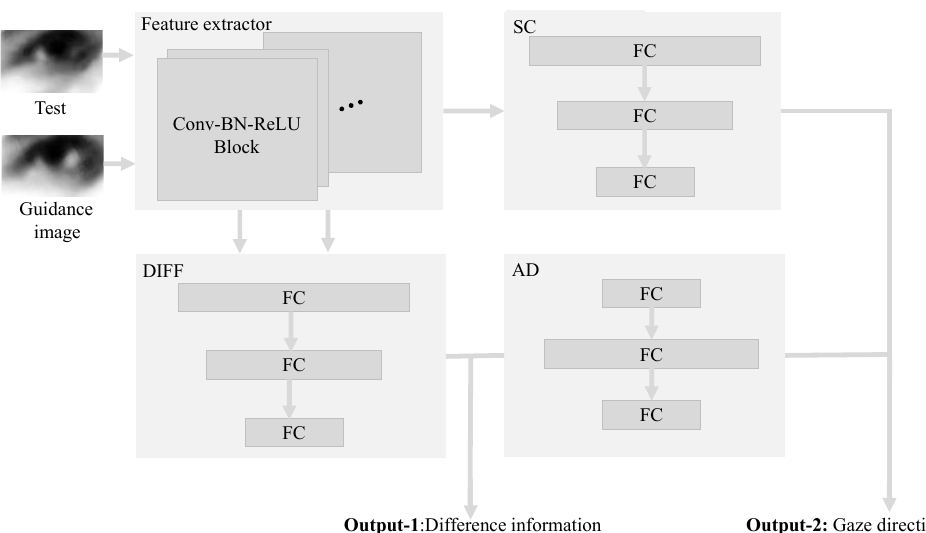
Figure 4. The proposed DRNet pipeline. Test and guidance images used as input to the DRNet model. DRNet provides the difference information and the gaze direction, which are described by three-dimensional vectors.